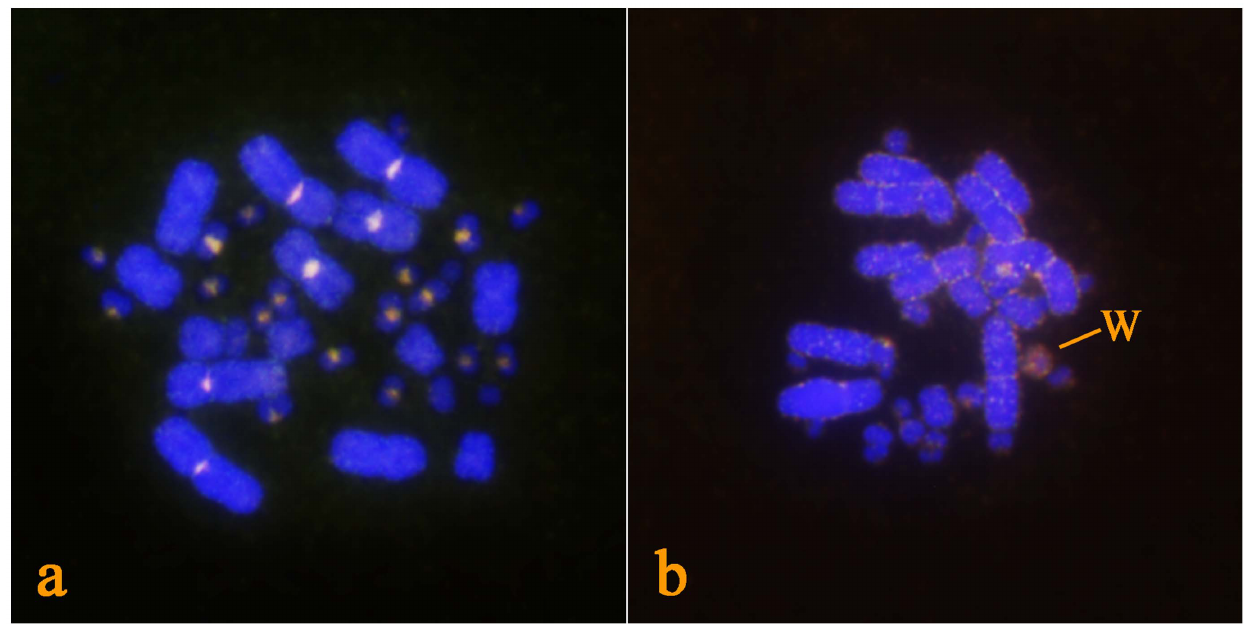
Figure 3. Results of CGH on male (a) and female (b) metaphase of H.suspectum . Male genome is stained with FITC (green colour), female genome with rhodamine (red colour). Regions common for genomes of both sexes are yellow (combination of green and red). The W chromosome is indicated on the female metaphase.